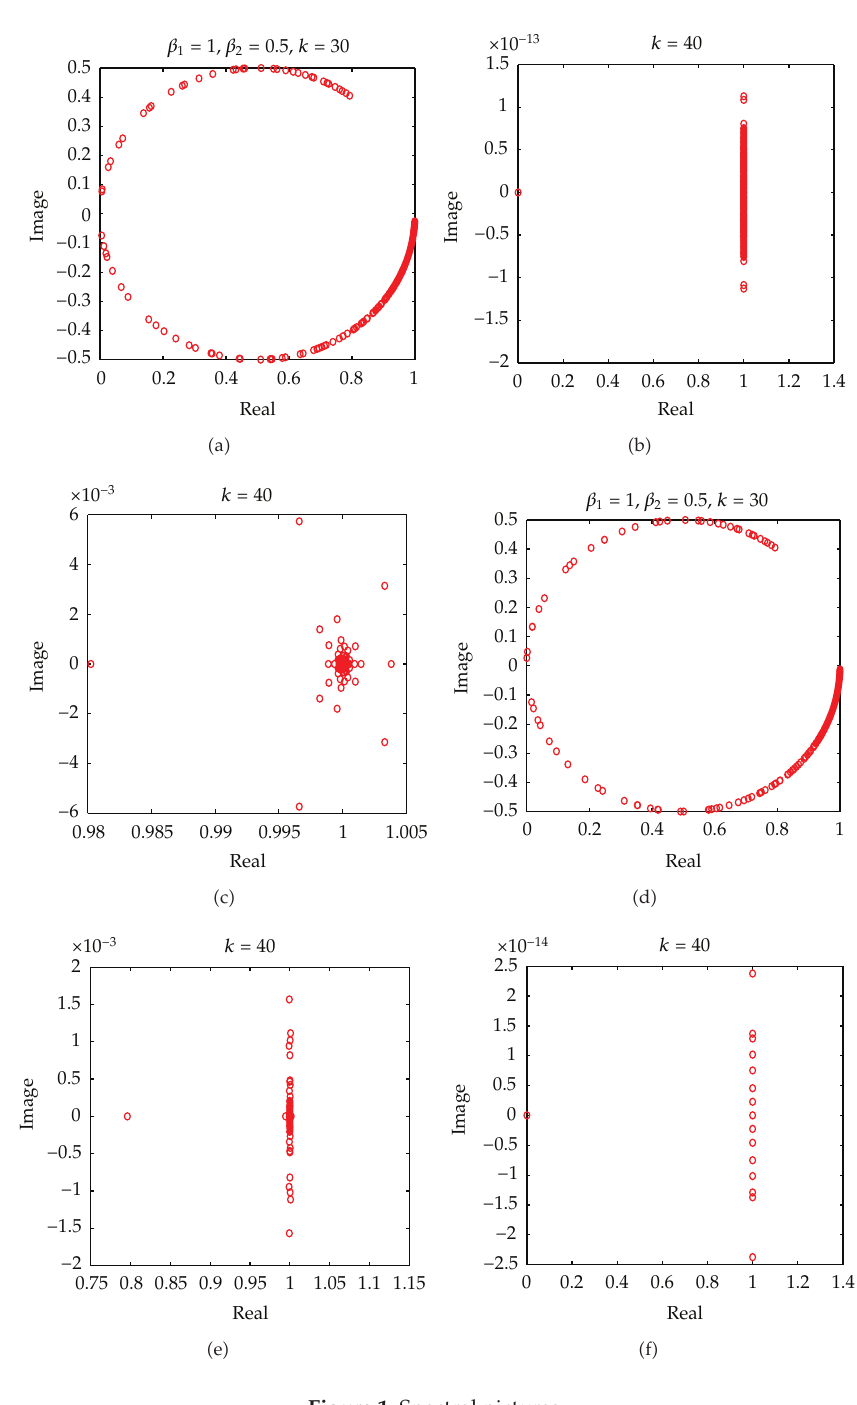
Figure 1: Spectral